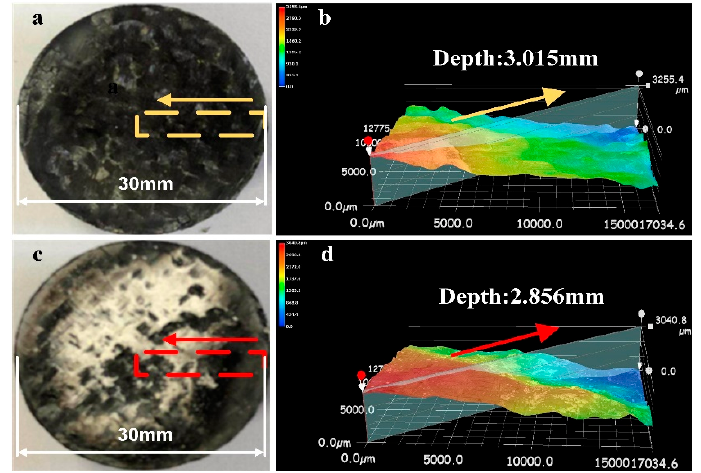
Figure 3. Ablation morphology of the composite: ( a ) Unmodified composite, ( b ) 3D image of the unmodified composite, ( c ) the 2C-C–Ph composite, and ( d ) 3D image of the 2C-C–Ph